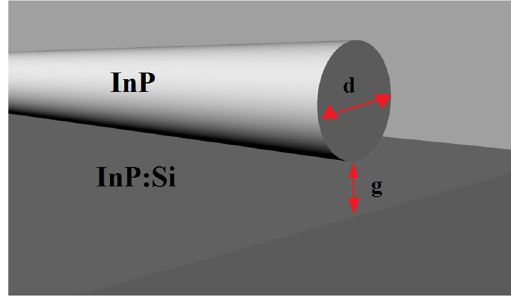
Figure 1. Schematic of the waveguide above a